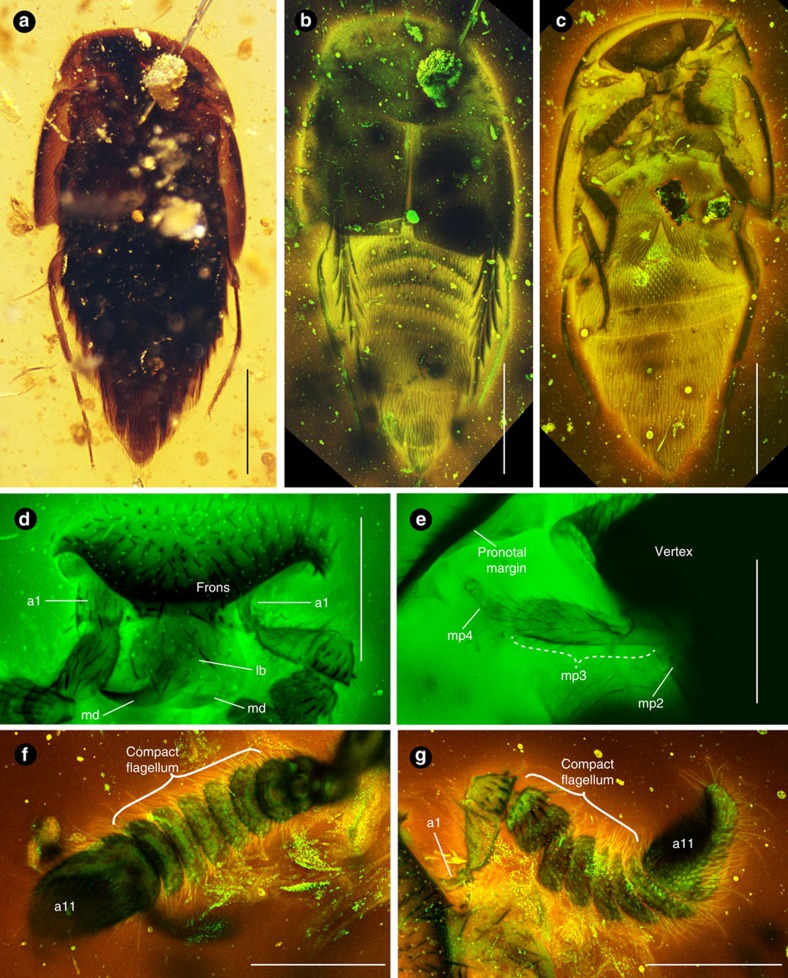
Mesosymbion compactus genus et species nova.(a–c) Habitus images of holotype AMNH Bu-SY5. Dorsal habitus, light microscopy (a), dorsal habitus, confocal reconstruction (b), ventral habitus, confocal (c). (d) Confocal image of frons showing falciform mandibles (md), labium (lb) and shielded antennal insertions (a1: antennomere 1). (e) Right maxillary palpus with palpomeres (mp2–mp4) indicated. (f,g) Left and right antennomeres, respectively, showing compaction of antennomeres 4–10 (a11: antennomere 11). Scale bars in a–c, 250 μm; scale bars in d–g, 75 μm.